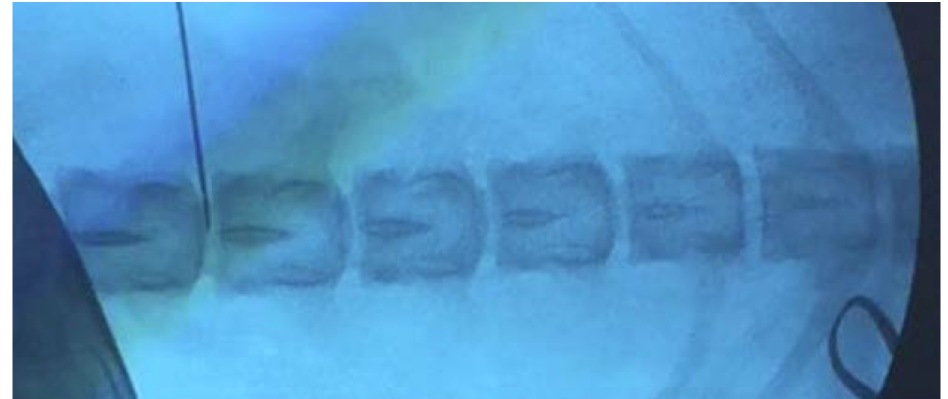
Figure 1. Representative image of fluoroscopically guided 20-gauge needle puncture injury into the L3/4